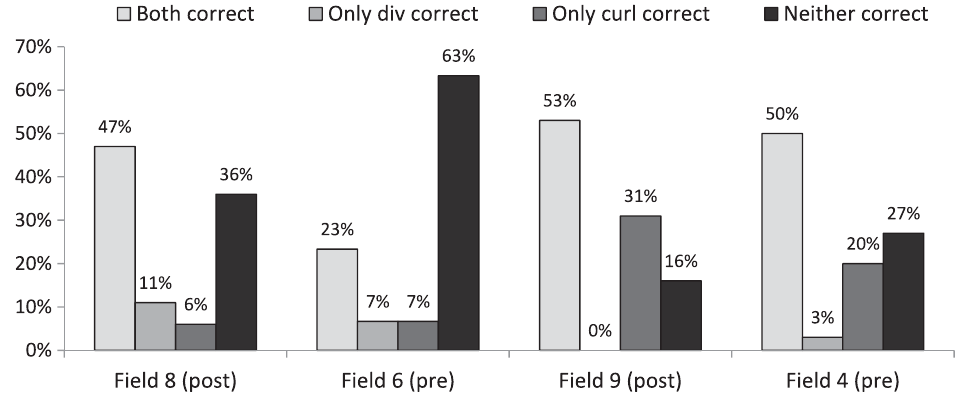
FIG. 2. Results for the context-free graphical representation of vector fields on the post-test ð N ¼ 19 Þ compared to the results on the pretest ð N ¼ 30 Þ . The first vector field on the post-test (Fig. 8) should be compared to Fig. 6 on the pretest, and Fig. 9 to Fig. 4.